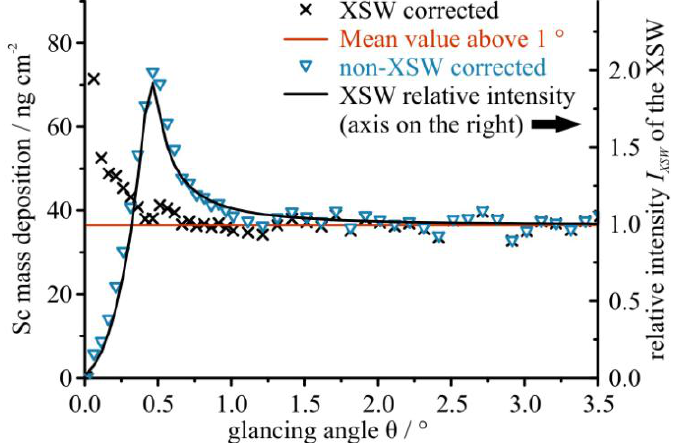
Figure 5. Plot of the Sc mass deposition (sample ID8) quantified for each glancing angle with (×) and without (  ) taking into account the XSW enhancement calculated in a non-iterative way as described in Section 3. In addition, the relative intensity of the XSW is plotted on the right axis (black